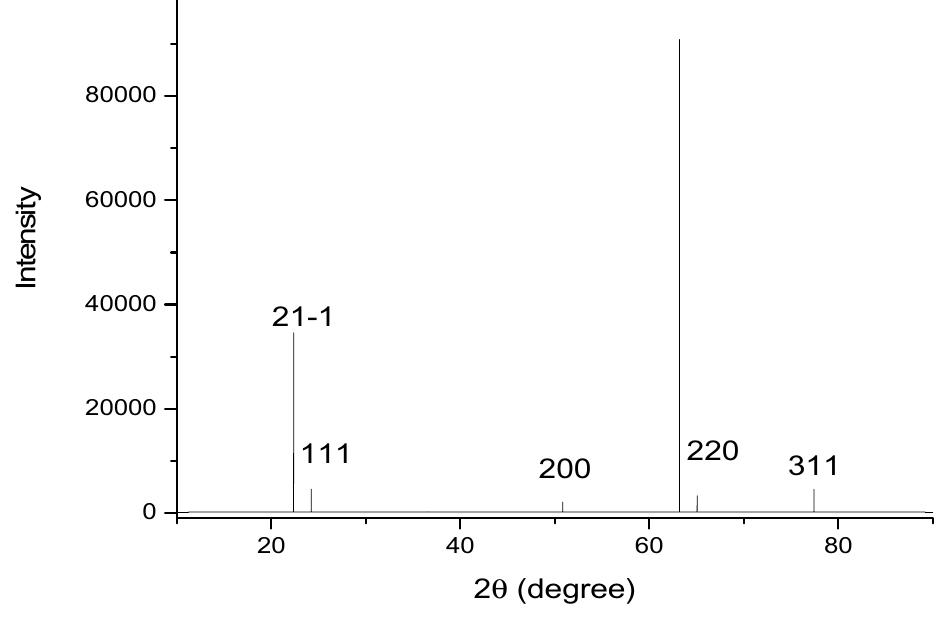
Figure 4. XRD pattern of green synthesized AgNPs using